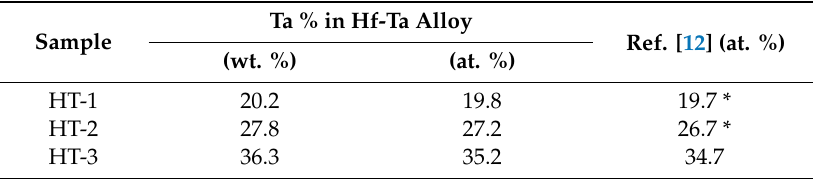
Table 1. Chemical compositions of the Hf-Ta alloy